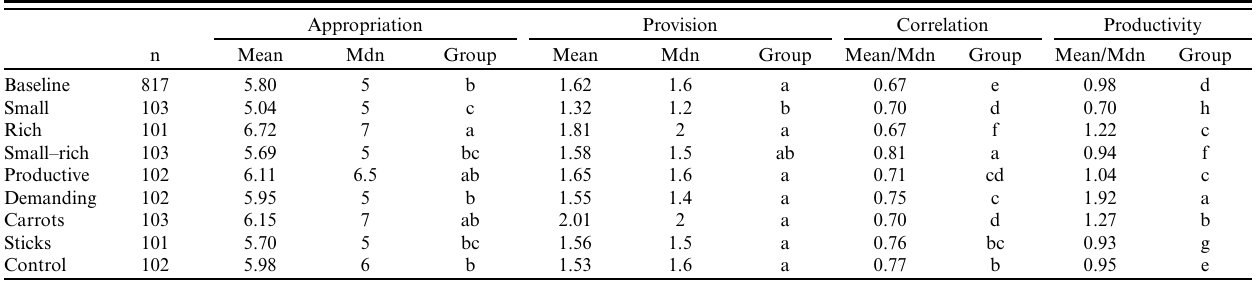
Table 2. Descriptive statistics and Dunn's pairwise comparison of treatments outcomes. Groups with different letters indicate significant differences between rank orders at alpha = 0.05. Appropriation Provision Correlation Productivity n Mdn Group Group Mean/Mdn Group Mean/Mdn Group